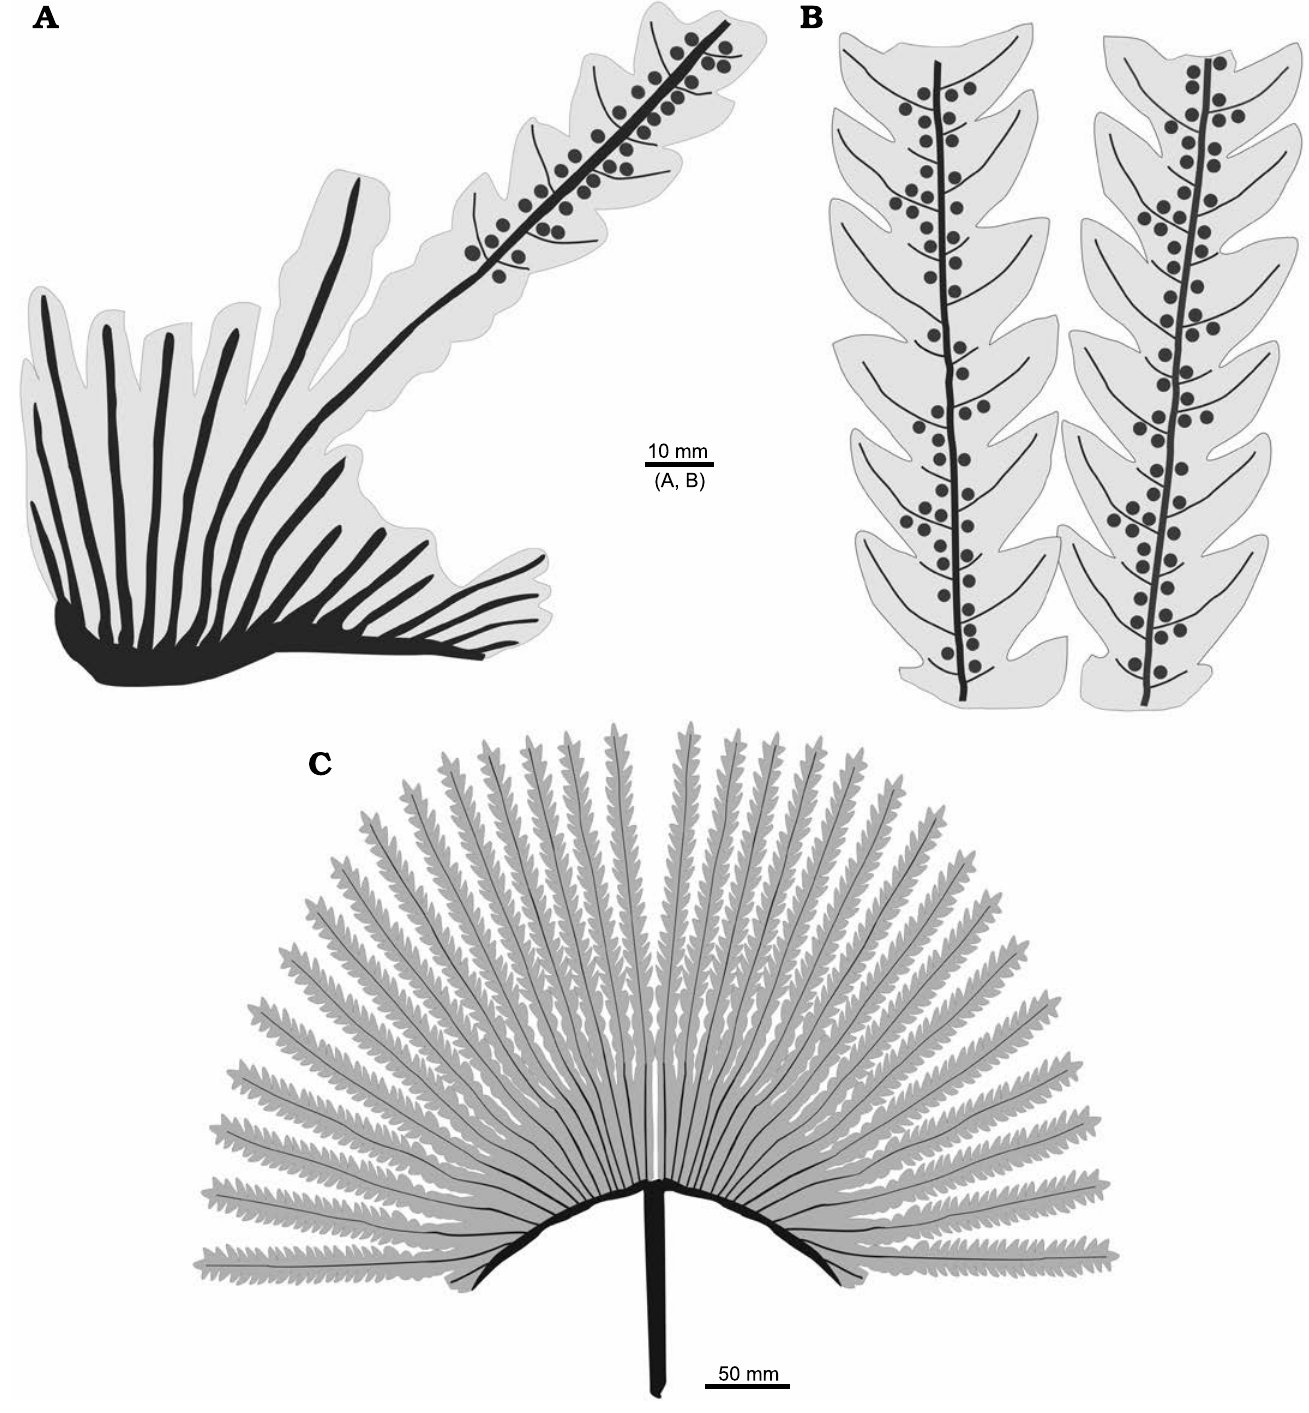
Fig. 5. Drawing of the dipteridacean fern Patagoniapteris artabeae gen. and sp. nov. from the upper Norian–Rhaetian, Upper Triassic Paso Flores Formation, Neuquén Province, Argentina. A . MCF-PBPH 066, basal portion of a rachial arm with the primary segments fused lamina. B . MCF-PBPH 415, primary segments of fertile frond with deeply dissected lobes. C . Hypothetical reconstruction of the frond. Fig. 4. Dipteridacean fern Patagoniapteris artabeae gen. and sp. nov. from the upper Norian–Rhaetian, Upper Triassic Paso Flores Formation, Neuquén Province, Argentina. A . MCF-PBPH 066, part of the frond showing fused and dissected portions. A 1 , A 2 , basal portion of a rachial arm with the lamina of the primary segments fused. A 3 , detail showing primary segments with the dissected portion of the lamina. B . MCF-PBPH 415, primary segments of fertile frond; B 1 , B 2 , deeply dissected lobes. C , D . Primary segments of sterile frond. MCF-PBPH 067d ( C ) and MCF-PBPH 069 ( D ). C, D 1 , deeply dissected lobes. D 2 , detail of a lobe of the primary segment, showing secondary and tertiary veins. Scale bars 10 mm.